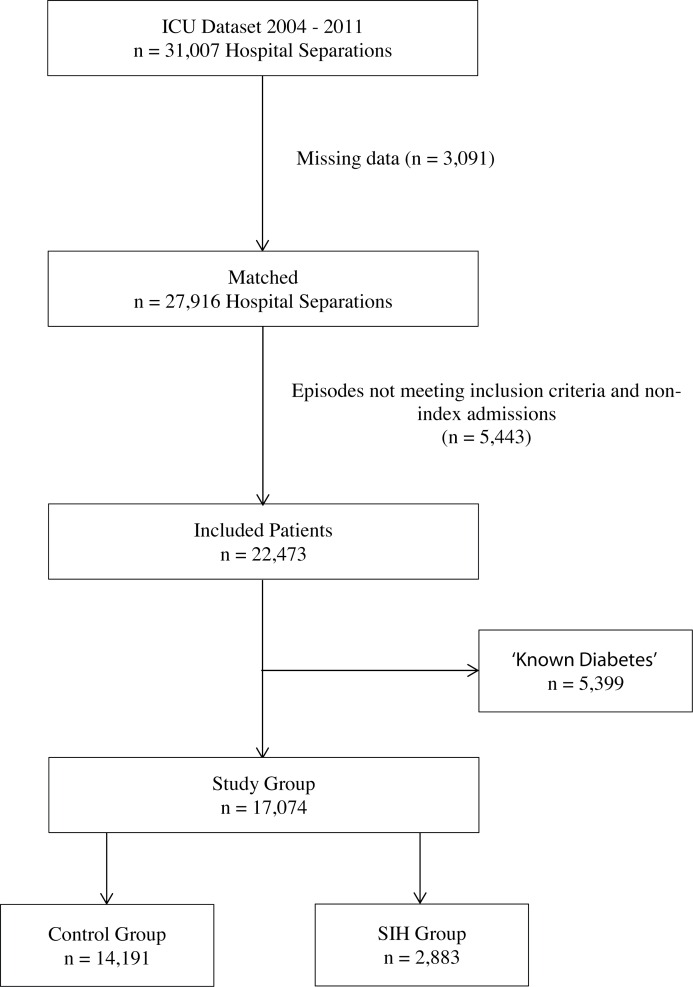
CONSORT style flowchart of patients included in analysis.SIH, stress induced hyperglycemia.